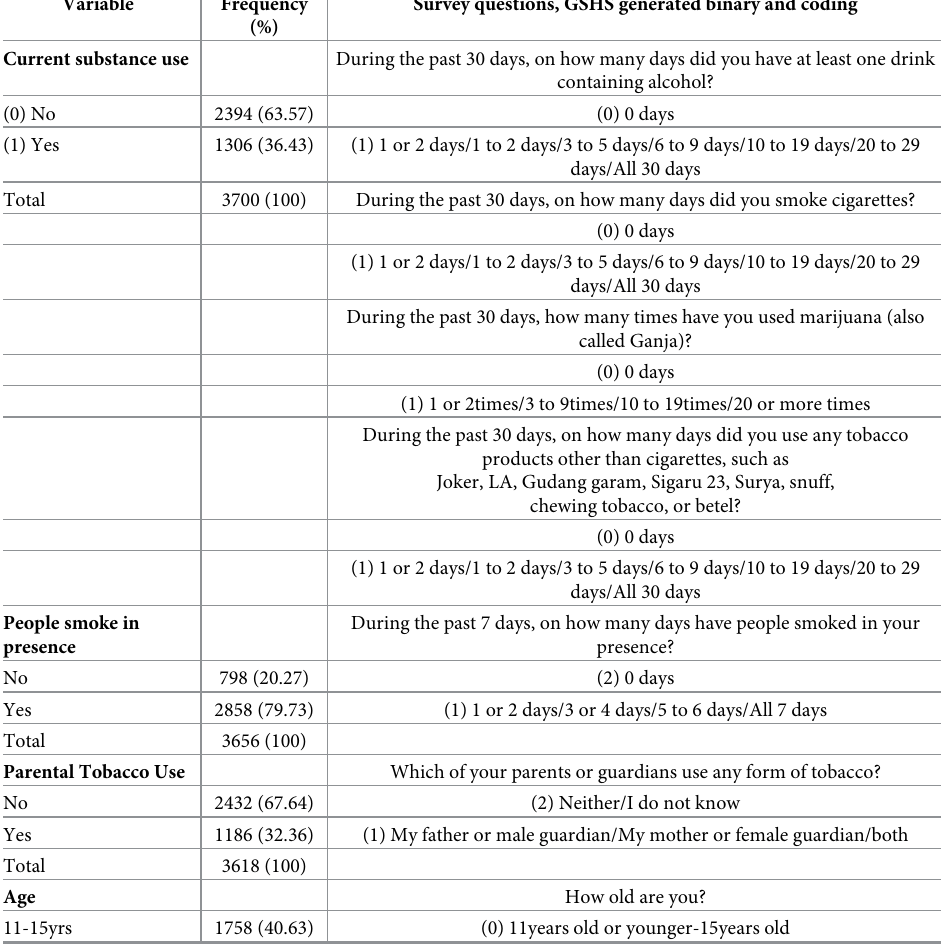
Table 1. Weighted socio-demographic characteristics of the of the students. Variable Frequency Survey questions, GSHS generated binary and (%)